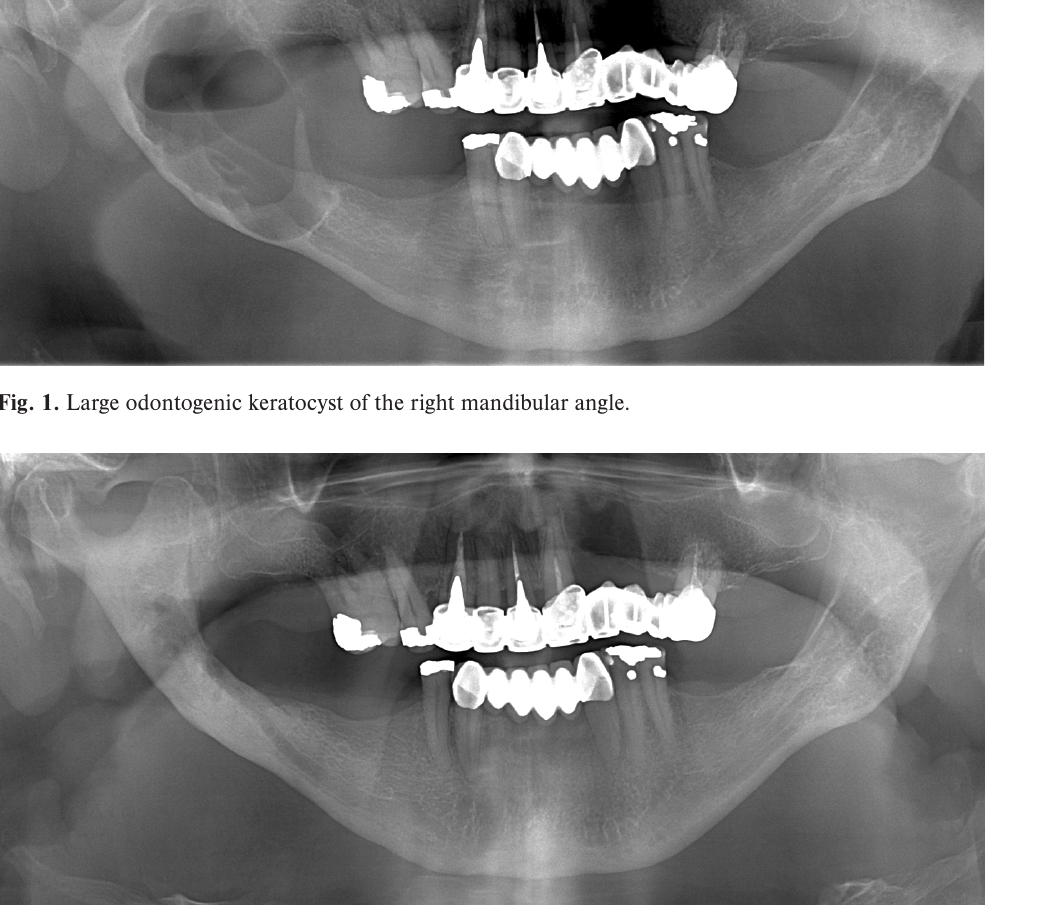
Fig. 2. X-ray finding 18 months after decompression and drainage of cystic